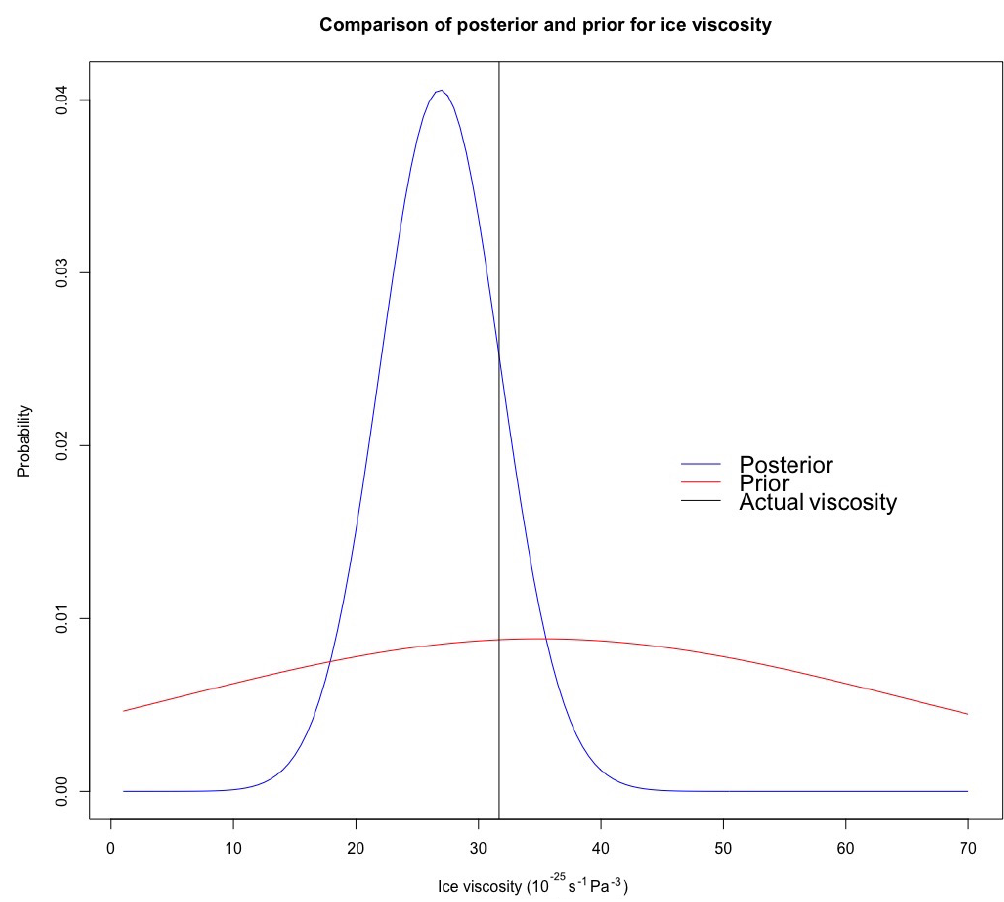
Figure 7. Comparison of posterior and prior distributions of ice viscosity for test case D (i.e., mass balance field producing a periodic SIA